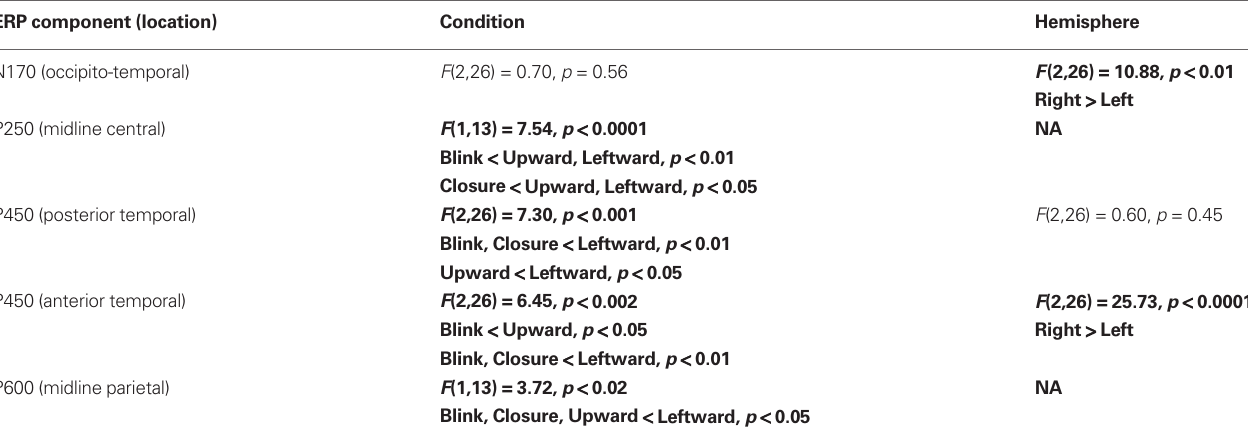
Event-related potential components and their scalp distributions are listed in the first column (These were selected from grand averaged topographic maps, see Figures 2 and 3 white dots). Main effects for Condition and Hemisphere are presented in the following two columns. Where a main effect was significant (bold text), comparisons evaluating the nature of the differences between the conditions appear directly below the entry. Scalp distribution for ERP components were centered on the Cz electrode at the vertex (midline central), the Pz electrode (midline parietal), as well as the anterior and posterior temporal, and occipito-temporal scalp in each hemisphere. NA = statistics for hemisphere were not available for ERP components centered on the midline